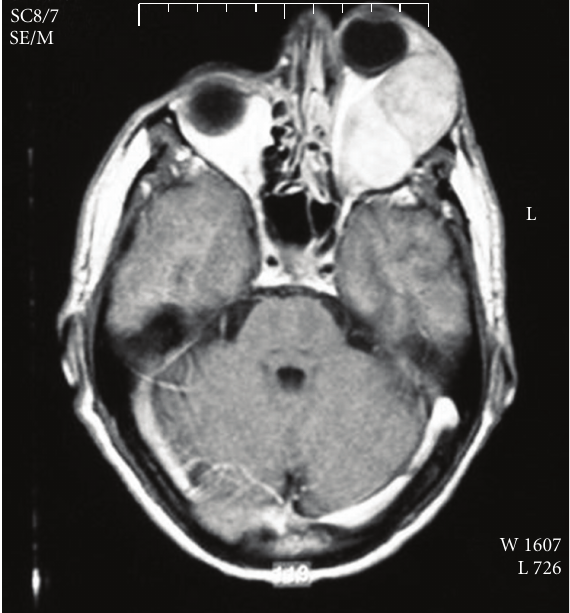
Figure 4: Left intraocular